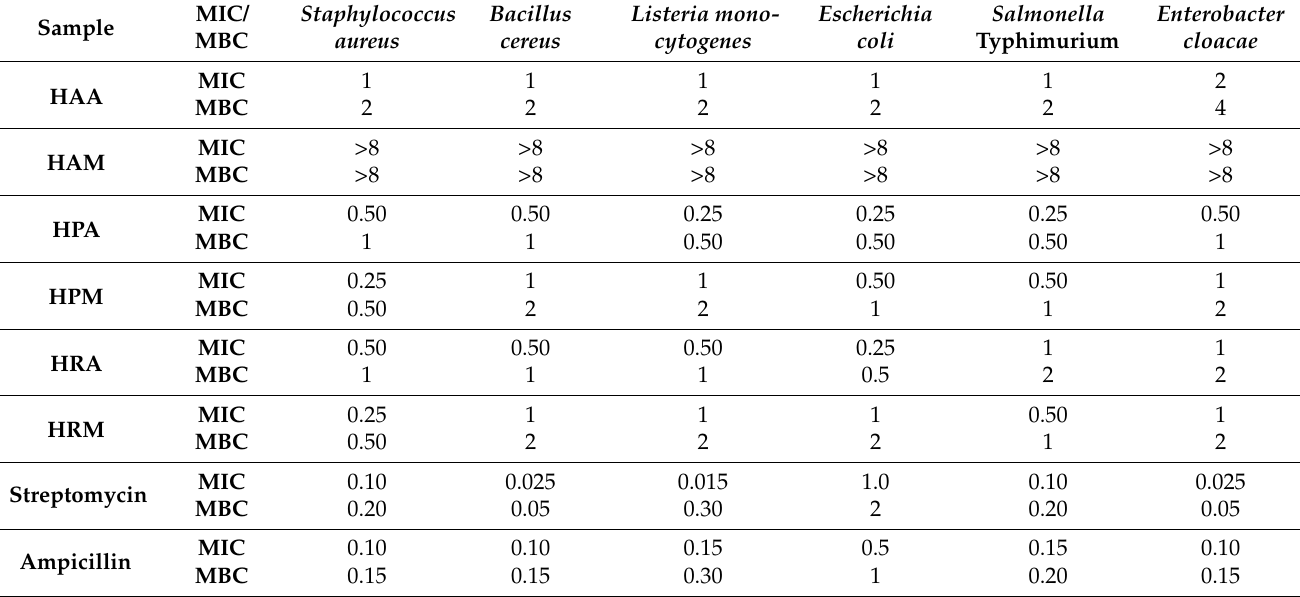
Table 4. Antimicrobial activity of Hypericum extracts. Streptomycin and ampicillin were used as control for bacterial growth. The results were given as minimum inhibitory concentration (MIC) and minimum bactericidal concentration (MBC) (all expressed as